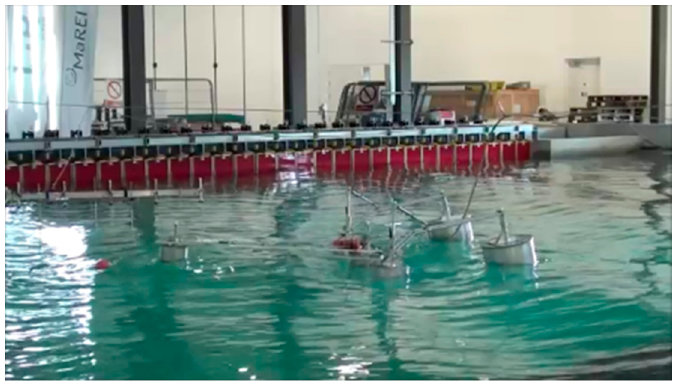
Figure 1. A video frame of the 6-float M4 with single mooring buoy (red, partly submerged) in the Lir ocean basin, University College Cork.